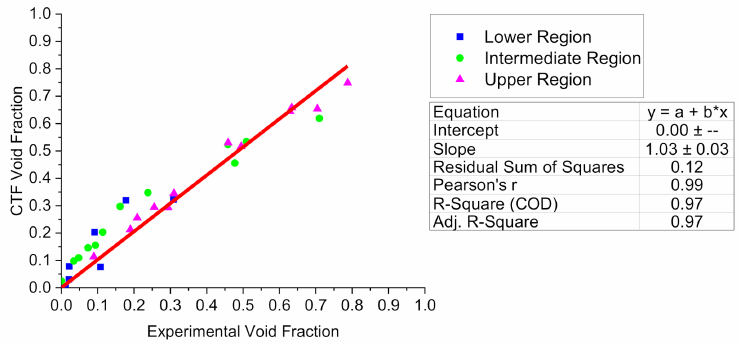
Figure 6. CTF vs. experimental void fraction.